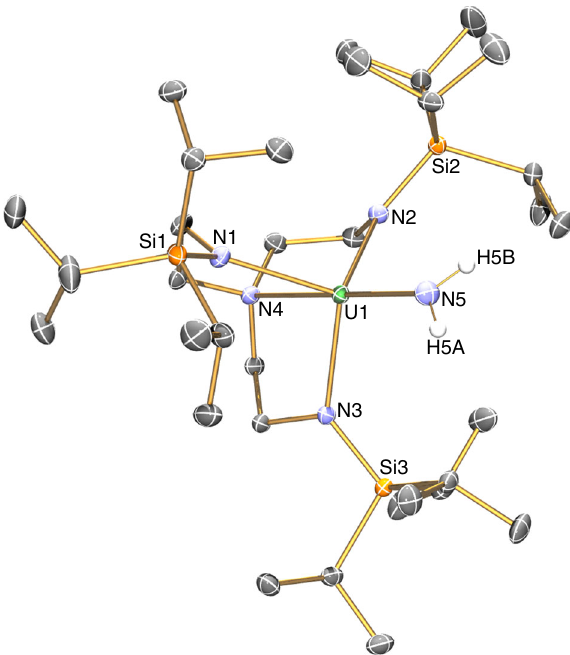
Fig. 5 Molecular structure of the anion component of 6 at 150 K and displacement ellipsoids set to 40%. Nonamide hydrogen atoms and the [K(B15C5) 2 ] + cation component are omitted for clarity. Selected bond lengths (Å): U1-N1, 2.393(2); U1-N2, 2.404(2); U1-N3, 2.385(2); U1-N4, 2.721(2); U1-N5,